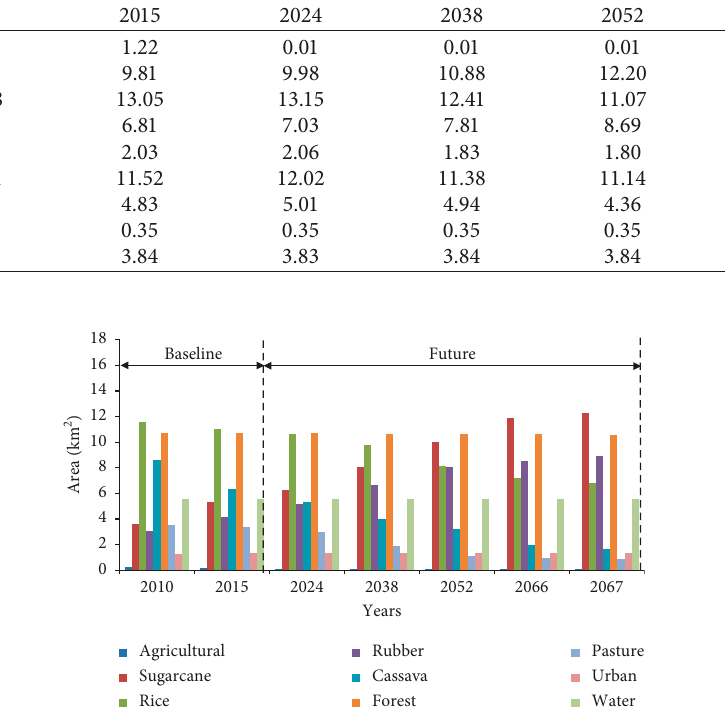
Figure 7: Historical and simulated land use areas above the Huay Sabag area.